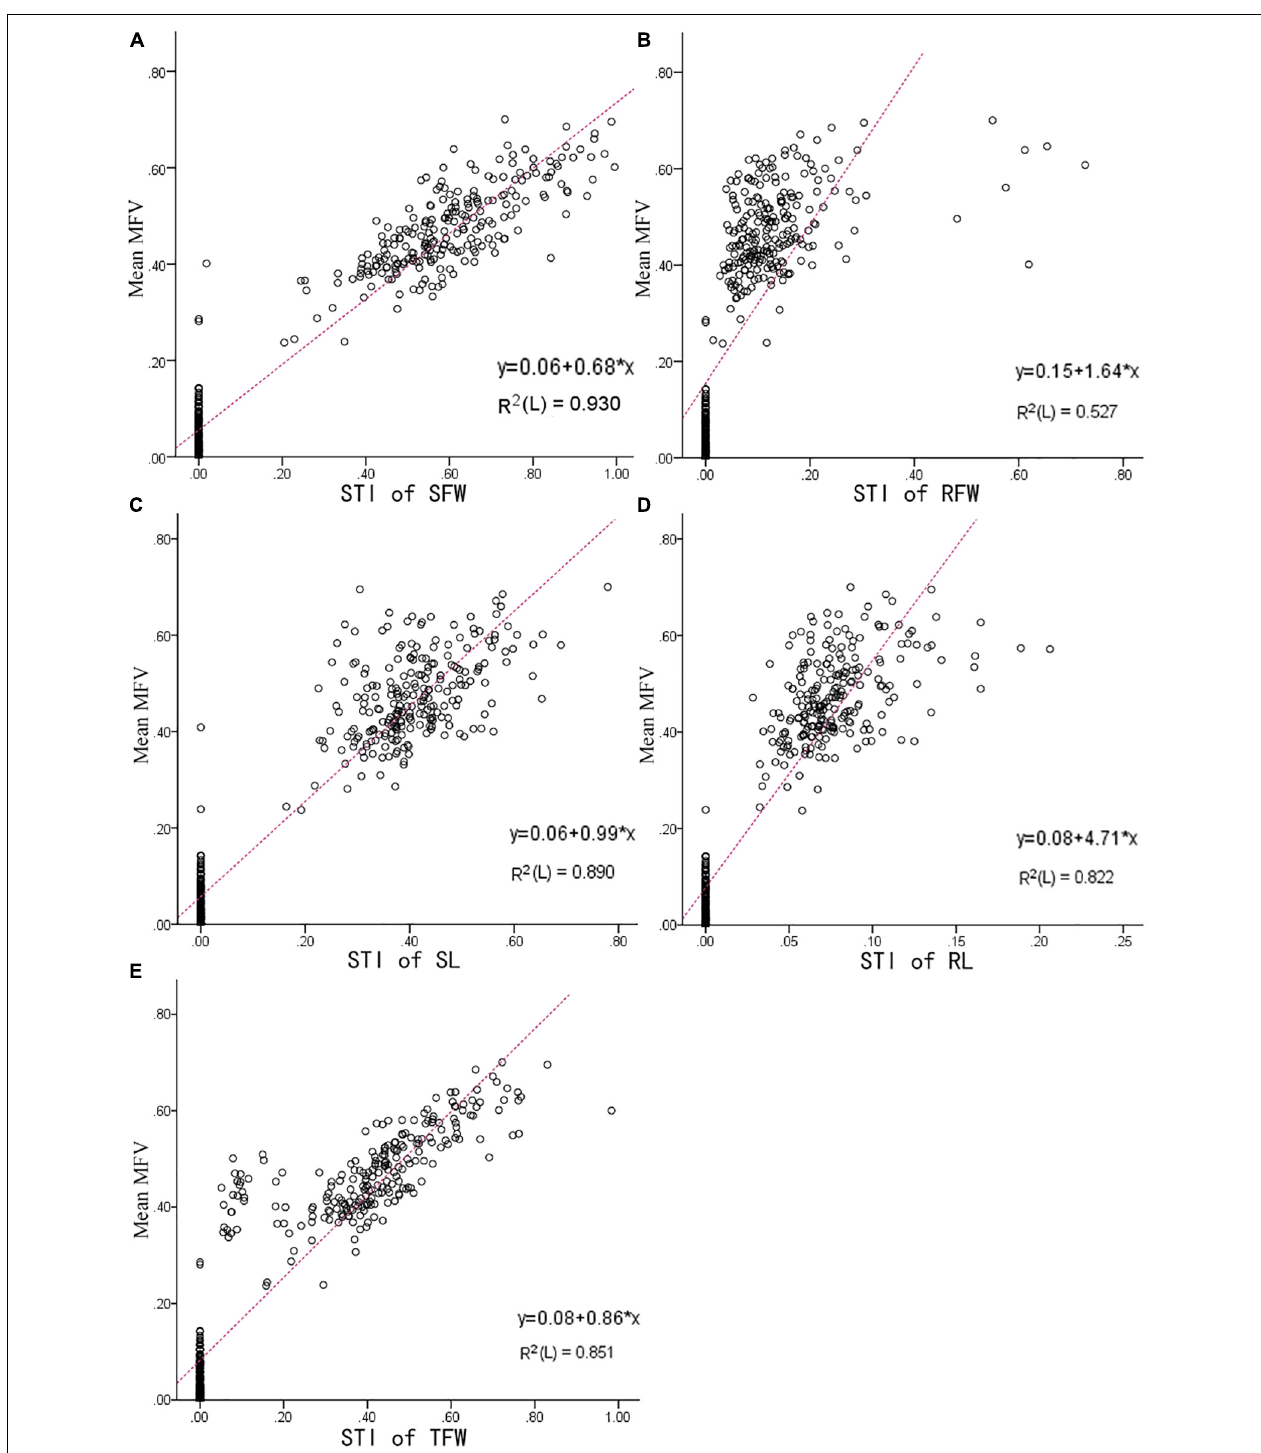
FIGURE 4 | The linear fit between the STI of each indicator and the mean MFV of an individual B. napus inbred line (438 B. napus inbred lines with different tolerances to salt stress). (A) Is between Mean MFV and STI of SFW (salt tolerance index of shoot fresh weight); (B) is between Mean MFV and STI of RFW (salt tolerance index of root fresh weight); (C) is between Mean MFV and STI of SL (salt tolerance index of shoot length); (D) is between Mean MFV and STI of RL (salt tolerance index of root length); (E) is between Mean MFV and STI of TFW (salt tolerance index of total fresh weight).